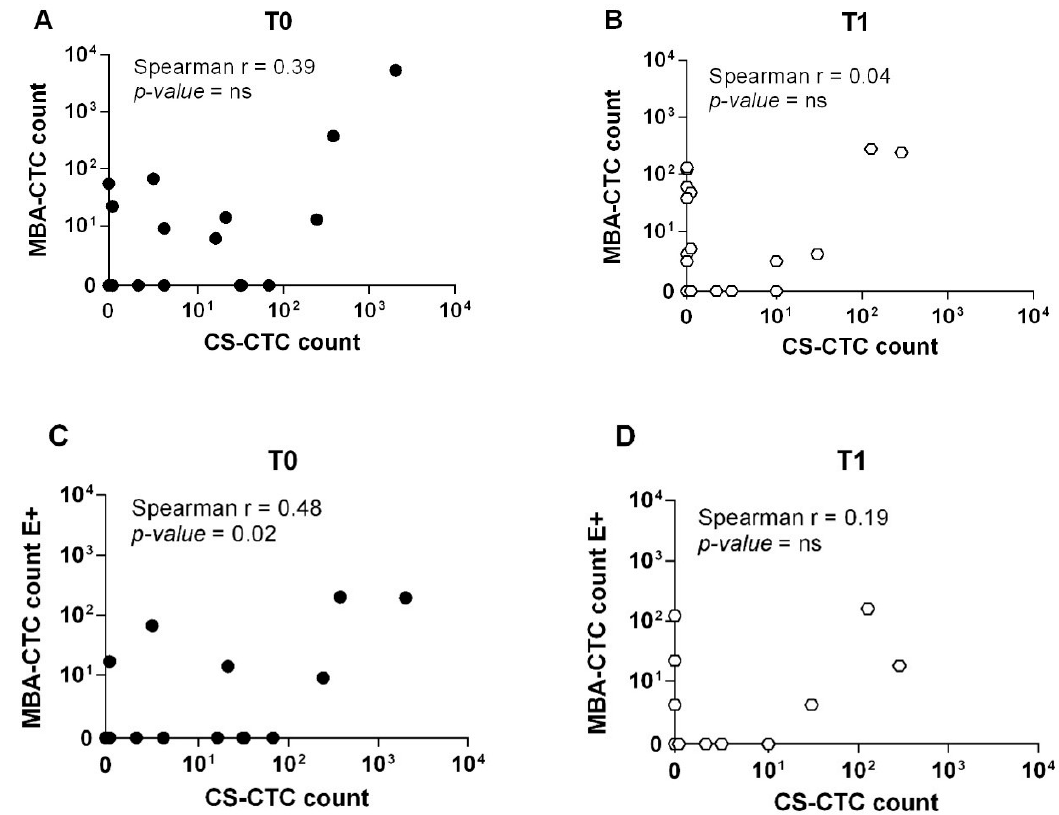
Figure 2. Direct comparison of CTC enumeration between the MBA and the CellSearch method. ( A ) Scatterplot of CTC count as detected by the MBA and the CS method at baseline (T0) and ( B ) follow-up (T1). ( C ) Scatterplot of EpCAM-positive CTC as detected by the MBA and the CS methods at baseline (T0) and ( D ) follow-up (T1). Only complete pairs of data including results from both MBA and the CS method were plotted. Overall, 22 and 21 cases had matched blood sample at T0 and T1, respectively.